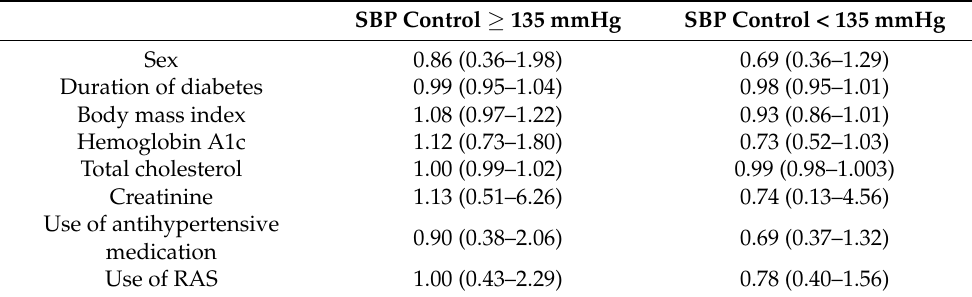
Table 6. The odds of each adjusting factor for the development of diabetic nephropathy according to systolic blood